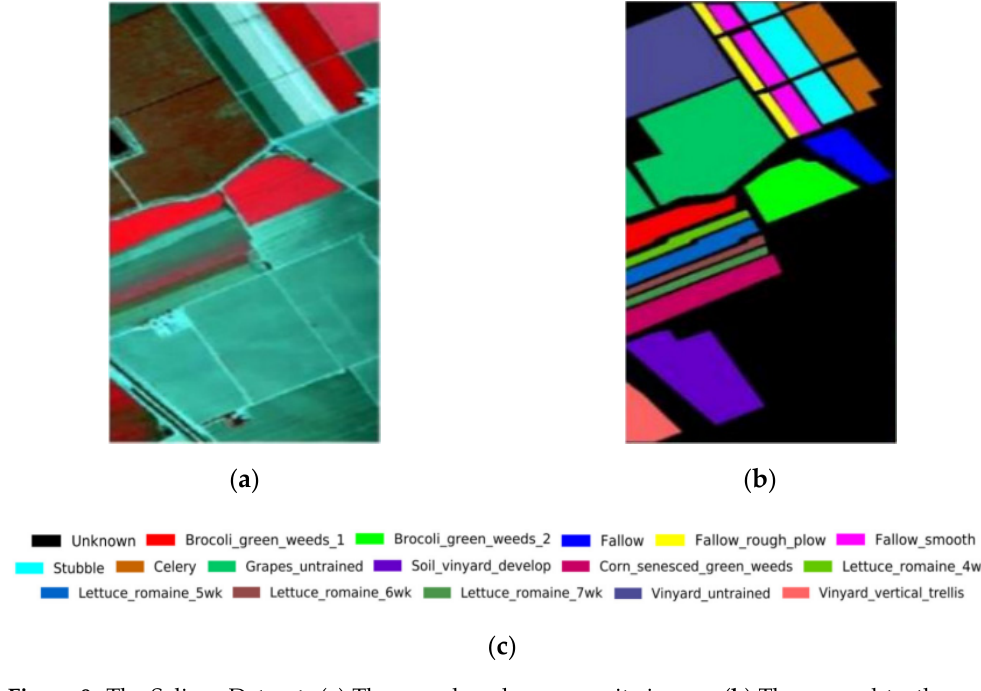
Figure 9. The Salinas Dataset. ( a ) The pseudo ‐ color composite image. ( b ) The ground ‐ truth map. ( c ) The corresponding color labels. Table 1. The number of samples used for training and testing in the IP dataset.